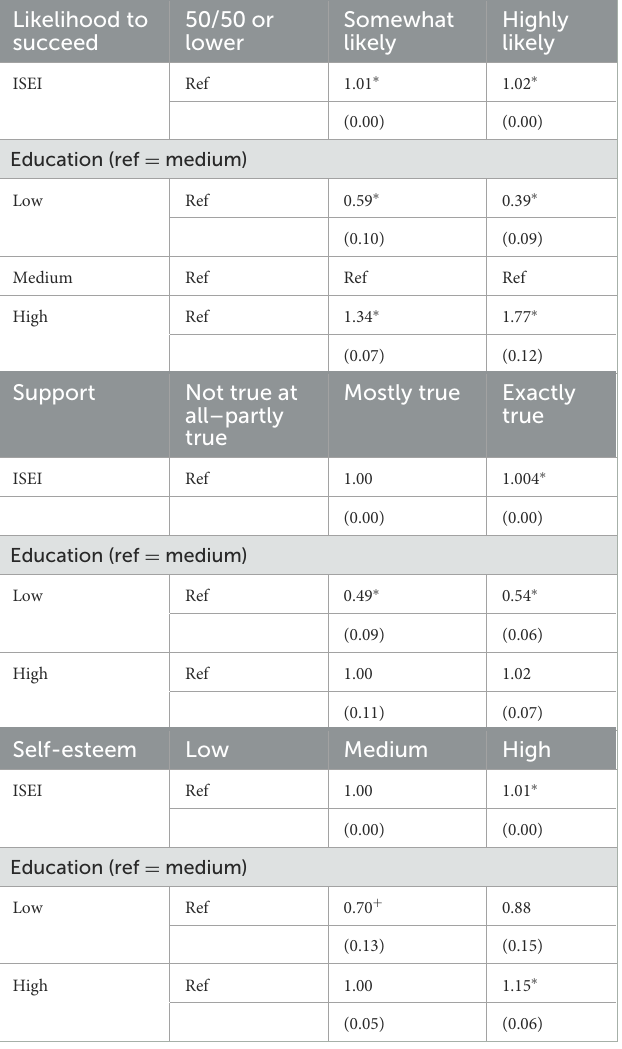
50/50 or Somewhat Highly lower likely likely